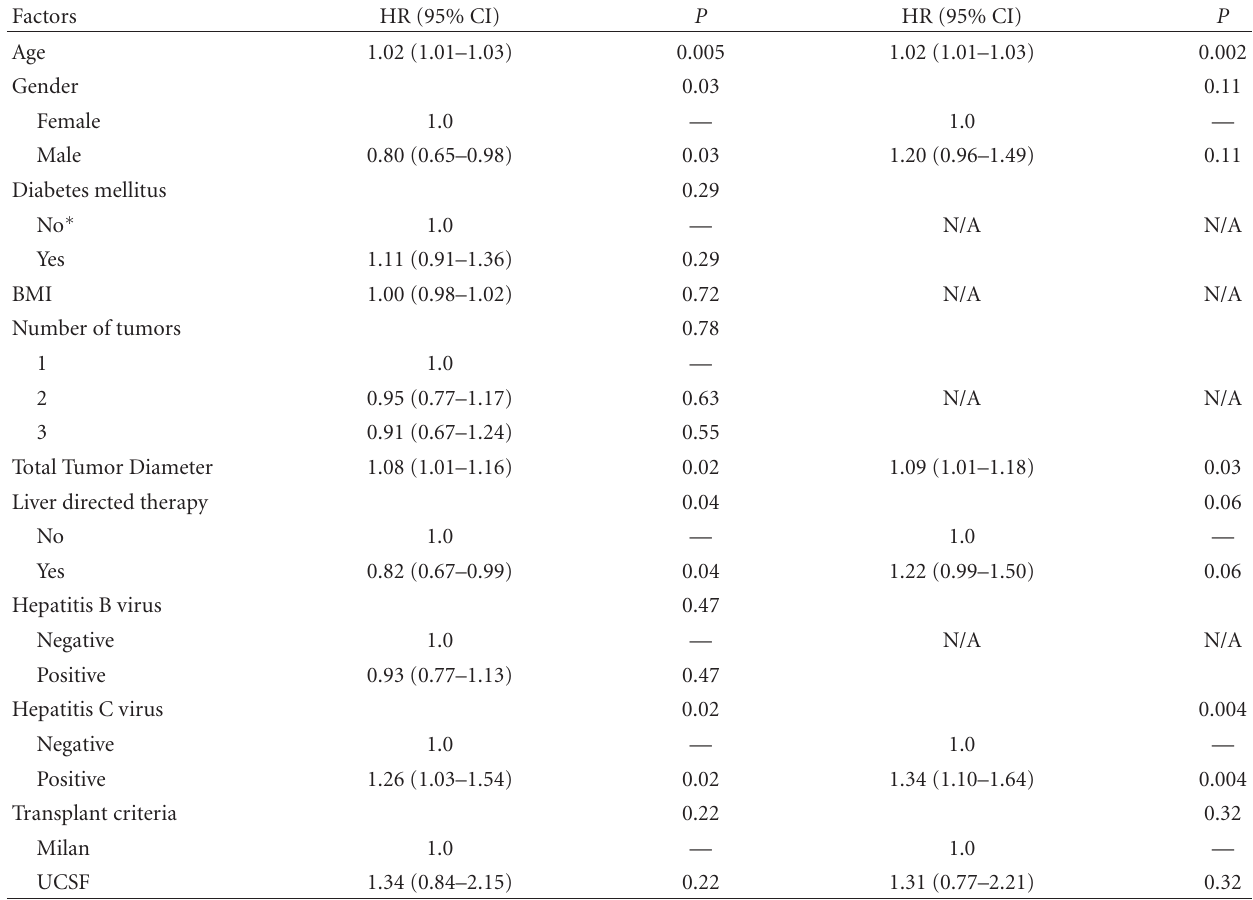
Table 3: Univariate and multivariate